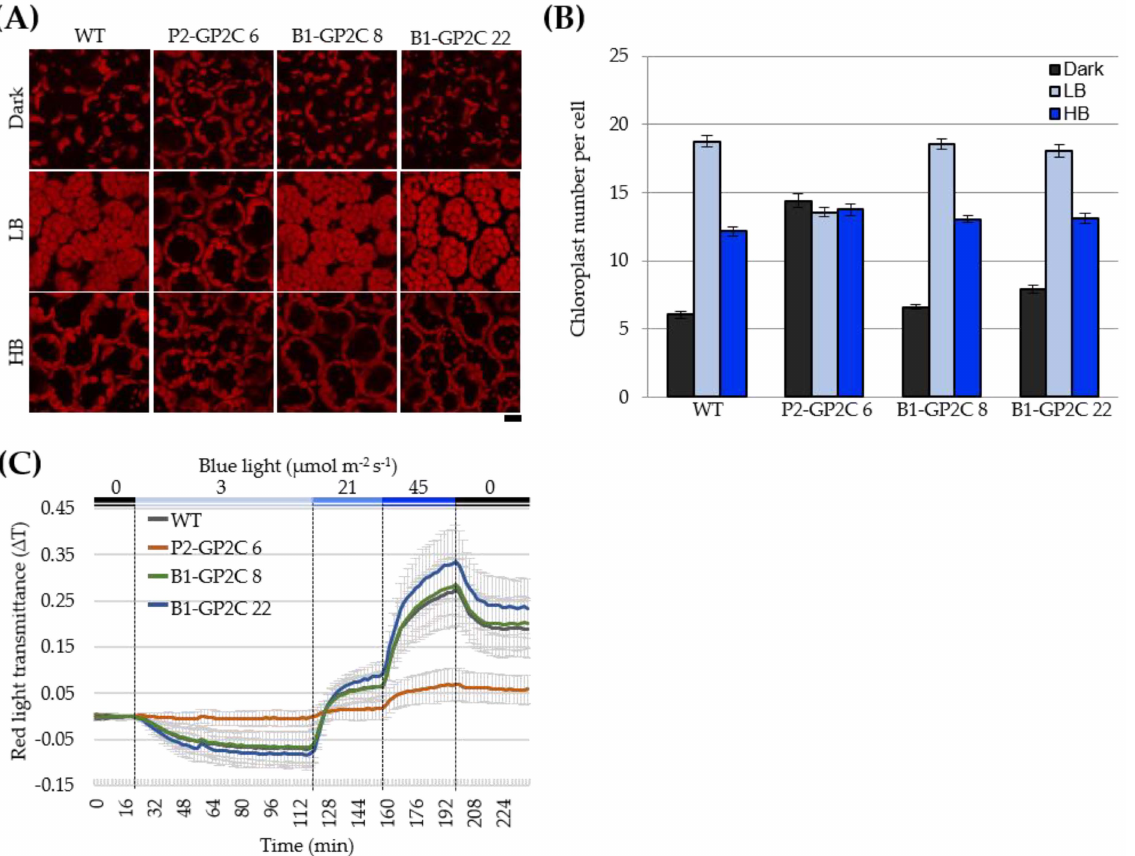
Figure 2. Chloroplast photorelocation movement in WT, P2-GP2C, and B1-GP2C plants. ( A ) Chloro- plast positioning in different light conditions. The third and fourth rosette leaves were detached from 3-week-old Arabidopsis plants and kept on agar plates containing 0.8% gellan gum in the dark for 14 h or under low intensity of blue light (LB, 2 µ mol m − 2 s − 1 ) for 3 h or high intensity of blue light (HB, 50 µ mol m − 2 s − 1 ) for 2 h. The rosette leaves were kept in the fixation buffer before observation. Chloroplast positioning was observed using confocal laser scanning microscopy. Scale bar = 10 µ m. ( B ) Chloroplast number in the palisade mesophyll cells of rosette leaves of WT, P2-GP2C, and B1-GP2C plants shown in ( A ). Data represent the mean ± SE ( n = 10 cells). ( C ) Changes in the red-light (RL) transmittance were traced in the third and fourth rosette leaves of 3-week-old Arabidopsis plants under different light conditions. The rosette leaves were sequentially irradiated with blue light at different intensities of 0 µ mol m − 2 s − 1 for 20 min, 3 µ mol m − 2 s − 1 for 100 min, 21 µ mol m − 2 s − 1 for 40 min, 45 µ mol m − 2 s − 1 for 40 min, and 0 µ mol m − 2 s − 1 for 40 min. Data represent the mean ± SE of three independent experiments ( n =